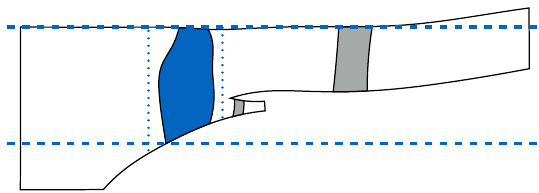
Figure 21. Definition of the alternative annular duct with uniform flow for the application of Goldstein’s analogy for the fan sources: the horizontal dashed lines define the duct radii, and the vertical dotted lines define the planes on which the variables are averaged.